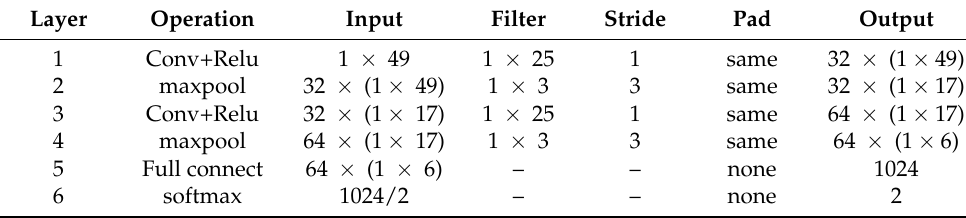
Table 1. The parameters of 1D-CNN